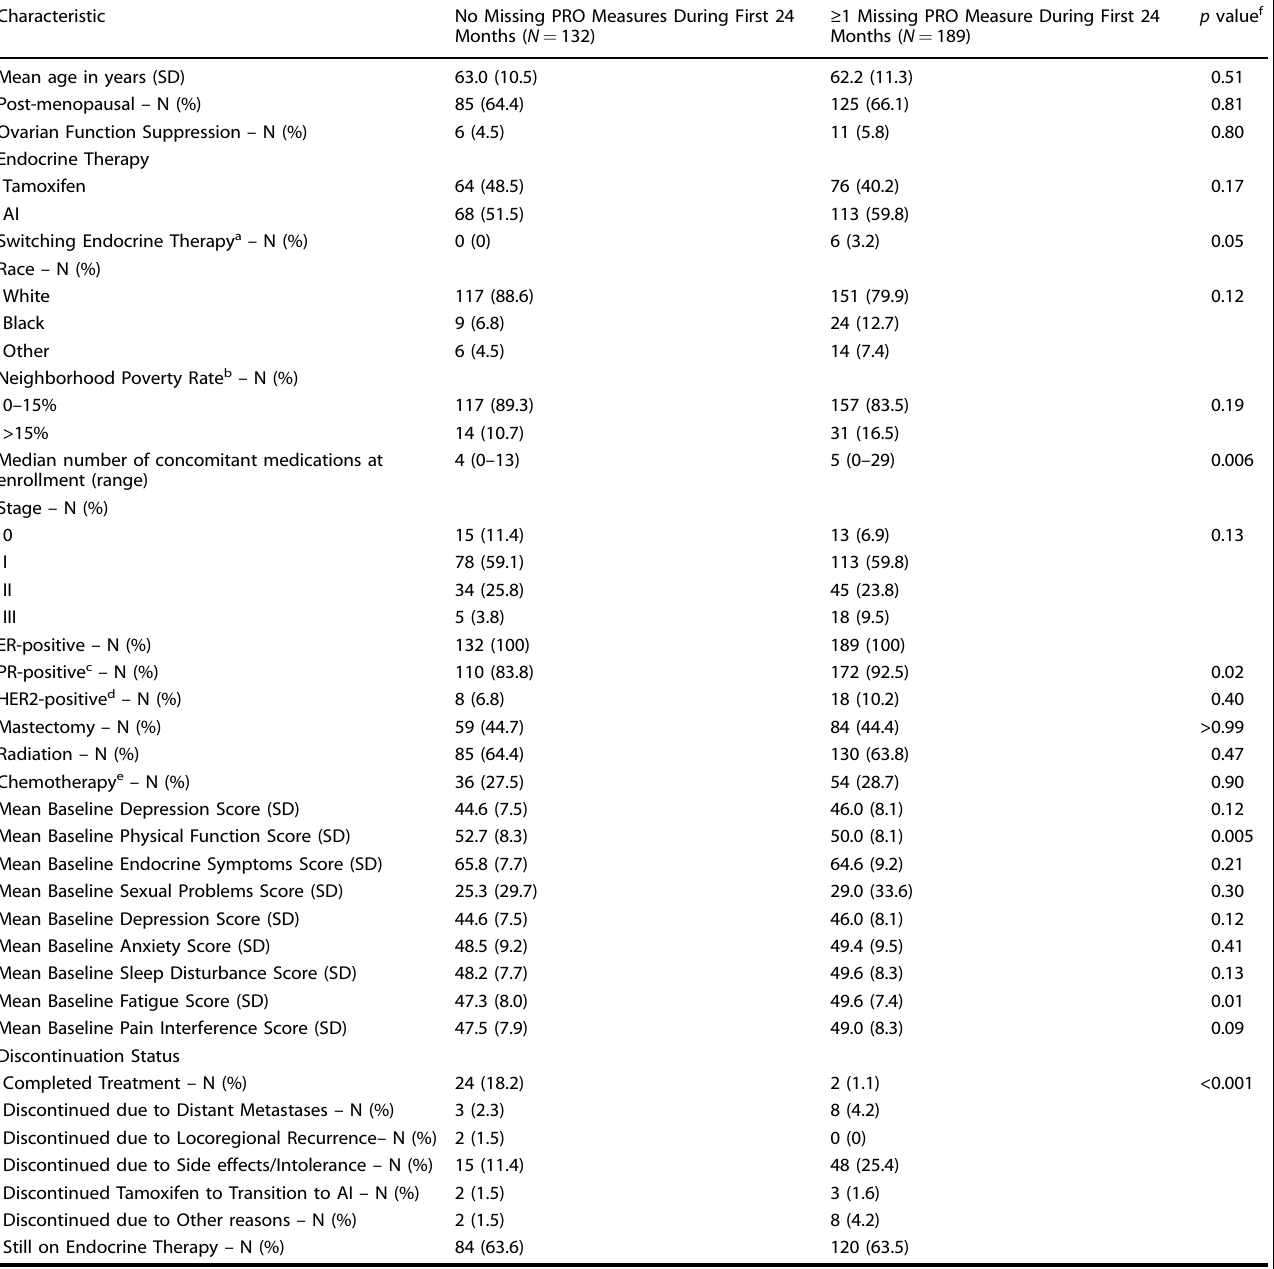
Table 4. Characteristics of participants with and without missing patient-reported outcome measures during the fi rst 24 months of study